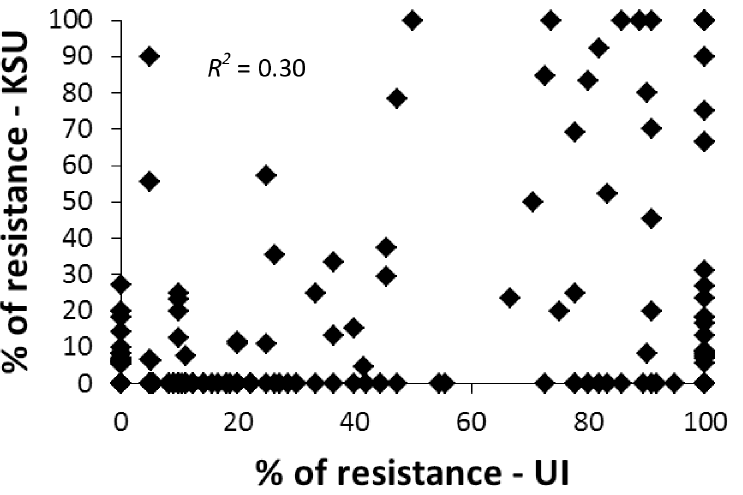
Fig 5. Scatter plot showing percentage of Northwestern elite spring wheat panel lines resistant to infection by two Hessian fly populations. R 2 for linear regression.